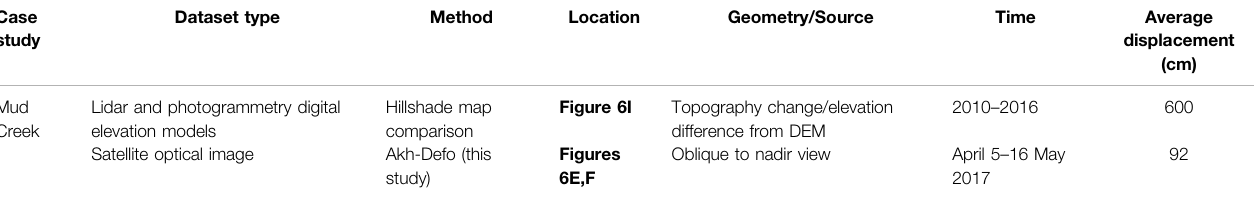
TABLE 2 | Average displacement from two independent datasets prior to the 20 May 2017, Mud Creek